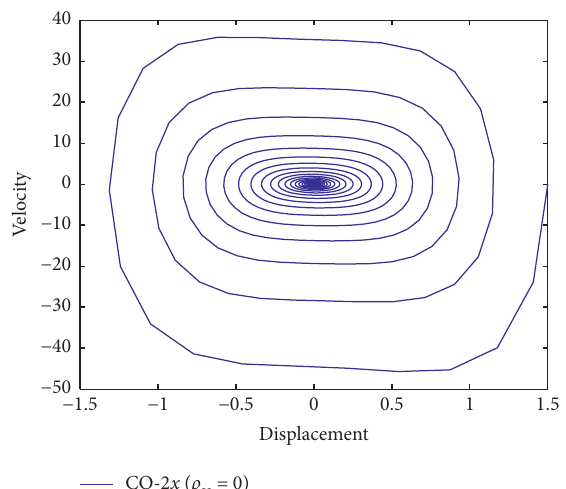
Figure 17: Phase portrait of the hardening spring calculated using � 0 ) when Δ t � T /20. CQ-2 x ( ρ ∞